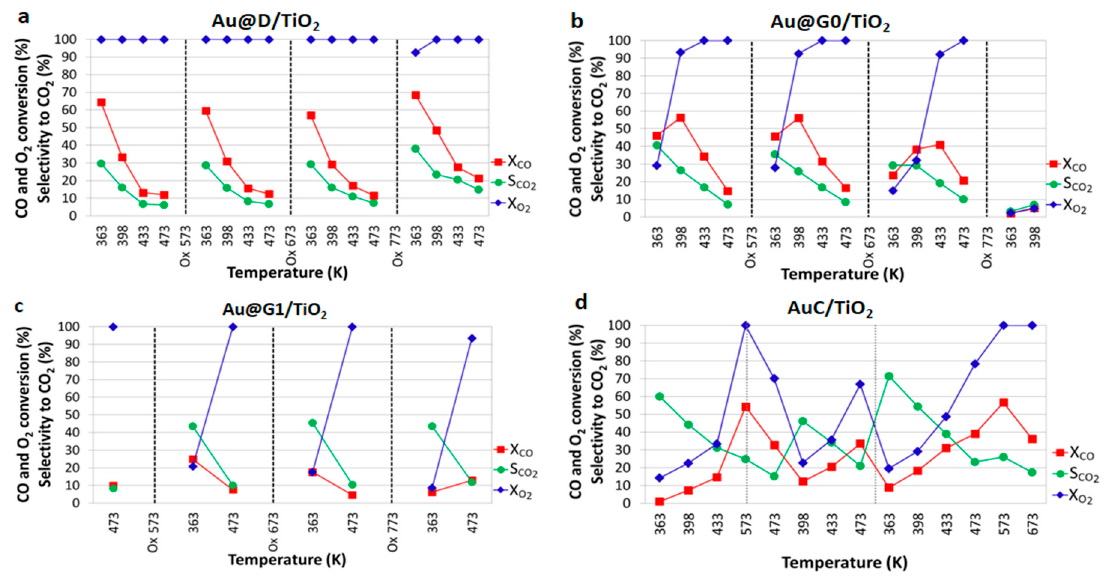
Figure 6. Temperature dependence performance of ( a ) Au@D / TiO 2 , ( b ) Au@G0 / TiO 2 , ( c ) Au@G1 / TiO 2 , and ( d ) AuC / TiO 2 catalysts for mixture C (2 vol.% CO, 2 vol.% O 2 , 50 vol.% H 2 , 46 vol.% Ar). Black vertical lines in ( a – c ) indicate the oxidations performed; grey lines in ( d ) show when mixture B was dosed at a higher temperature.